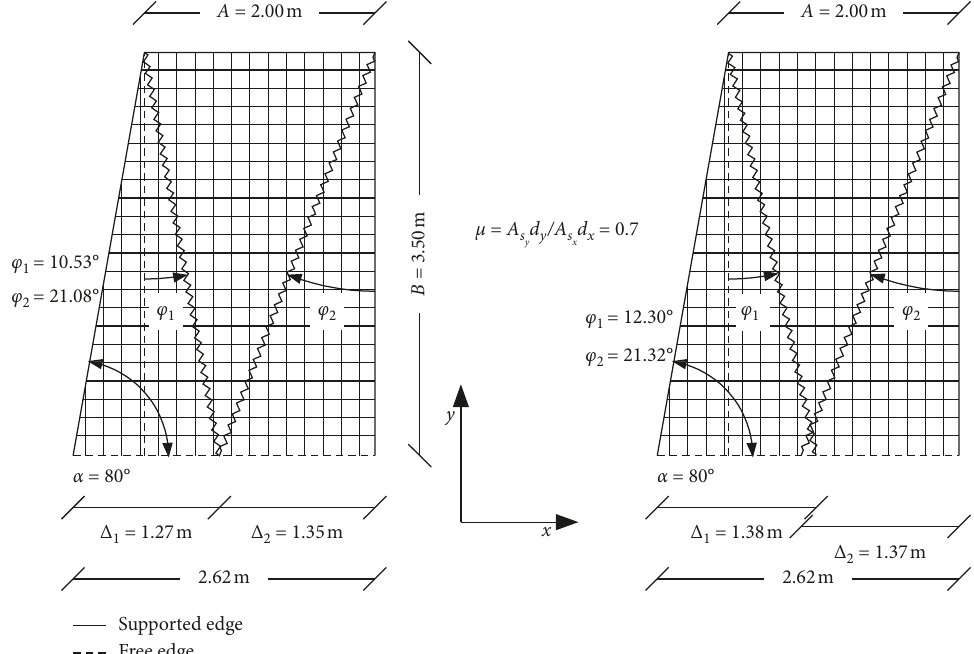
Figure 6: Effect of the penalty function coupled to the sequential simplex method when using the yield-line method for analysis of a trapezoidal R/C slab. (a) Constrained solution. The pseudo-objective function value